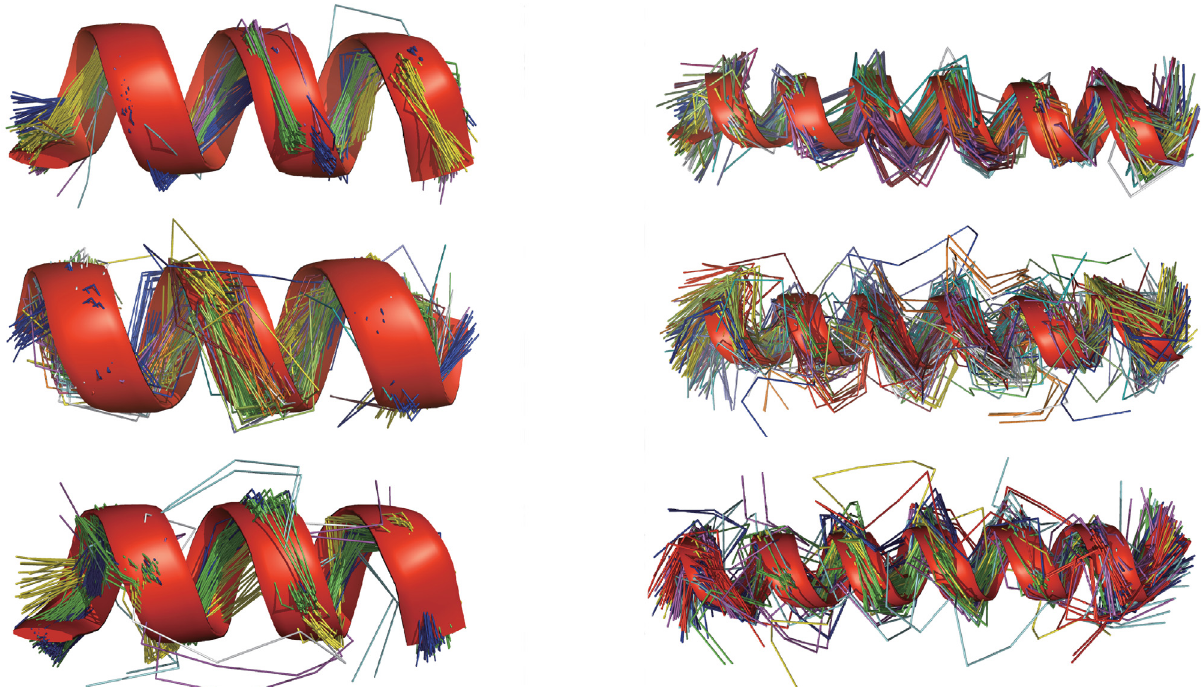
Fig 6. The clusters of α – helices by our algorithm, DSSP and P - SEA . The sets of helices in the left have a length of 12 residues while the sets in the right 24 residues. The 12-residue set (11,756 helices) and 24-residue set (1,211 helices) by our algorithm are classified respectively into 12 and 17 clusters. The DSSP assigned 12-residue set (12,631 helices) and 24-residue set (1,285 helices) are classified respectively into 21 and 35 clusters while the P - SEA assigned 12-residue set (5,306 helices) and 24-residue set (574 helices) are classified respectively into 10 and 24 clusters. The clusters are produced using our geometric clustering algorithm [22]. The RMSD threshold for clustering is 1.5 Å